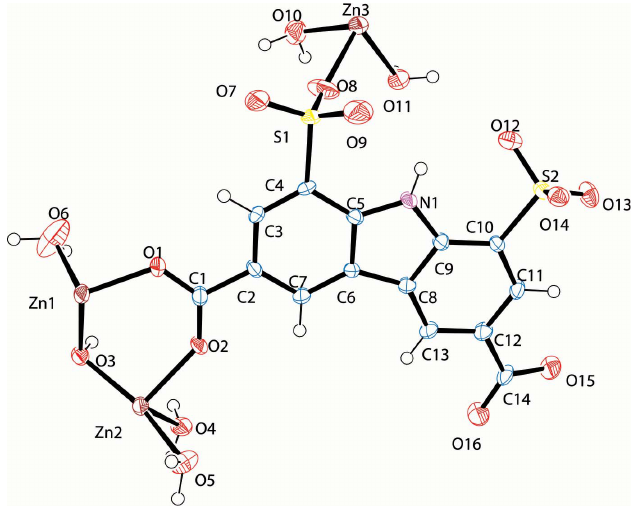
Figure 1 A view of the asymmetric unit of (I), showing the atom numbering, with displacement ellipsoids drawn at the 50% probability level.